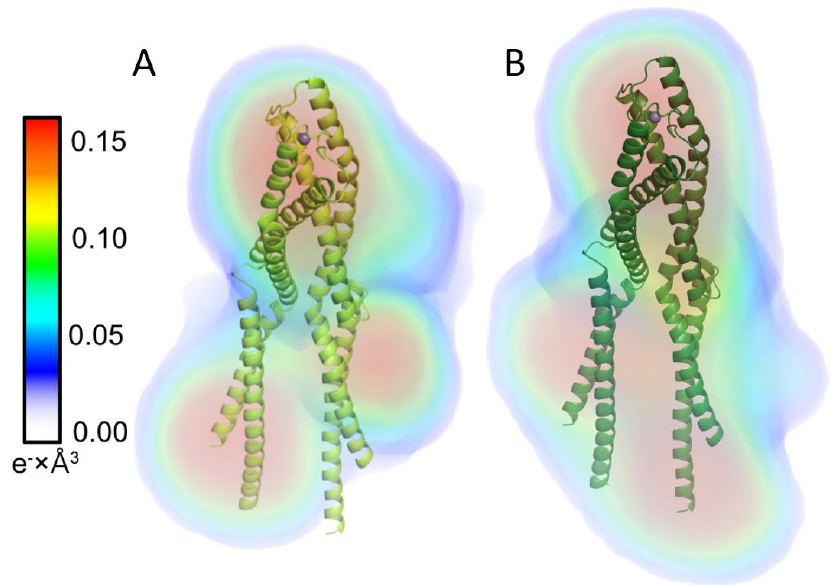
Figure 7. Electron density reconstruction from experimental solution scattering data for ( A ) Hs Hk183 and ( B ) Hs Hk183 T690E. Electron densities are shown as colored volumes. The color bar on the left indicates the electron density value in e − × Å 3 . X-ray crystal structure of Rad50 protein fragment is presented in cartoon format (PDB ID 5GOX). Hs Hk183 and phosphomimetic mutant form rod-shaped particles.